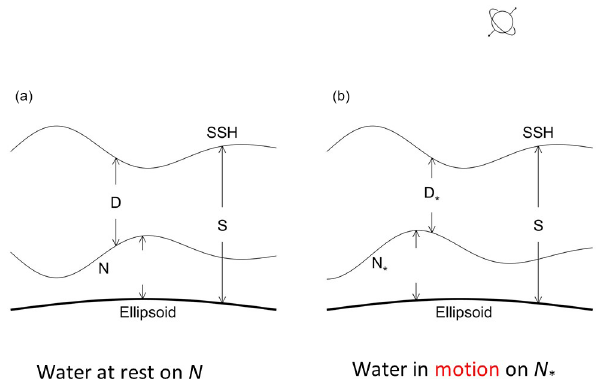
Figure 1. Two types of marine geoid and DOT: (a) the first type with N being the average level of SSH if water is at rest (classical defi- nition), and (b) represents the second type with satellite-determined N ∗ (water in motion on N ∗ )